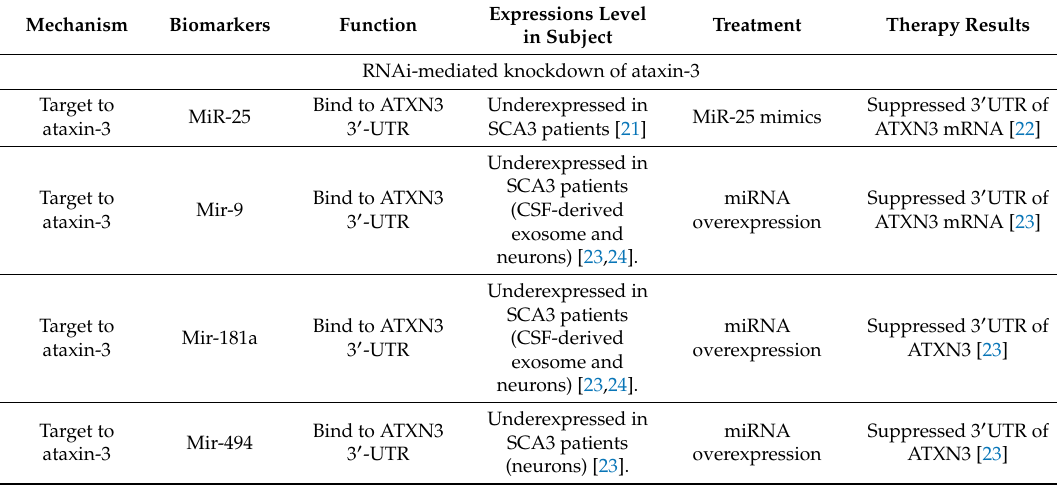
Table 2. Combination of the information from biological markers of SCA3 / MJD patients and the current therapeutic strategies against those expressed biological